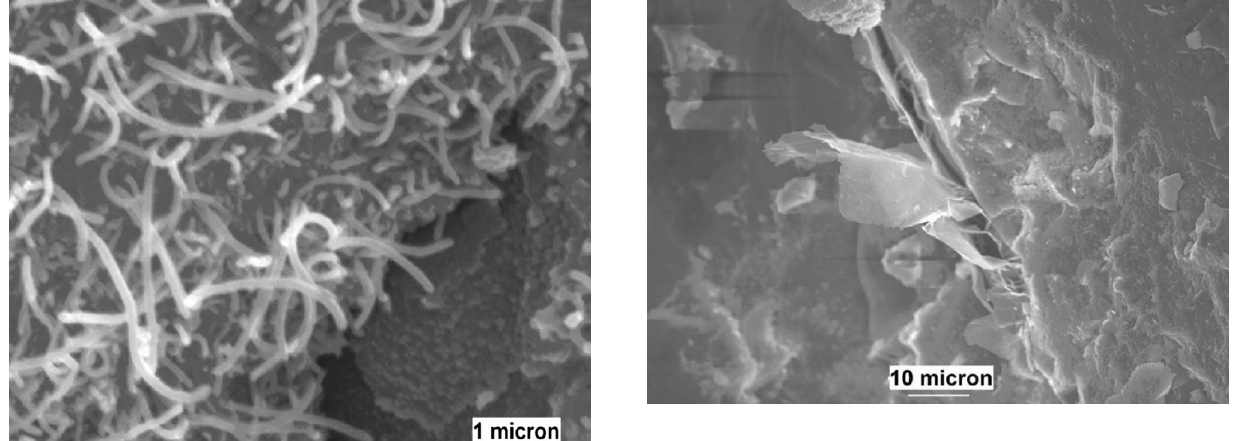
Fig. 14 SEM image of failed surface of UHPCM reinforced with 0.03 wt.%